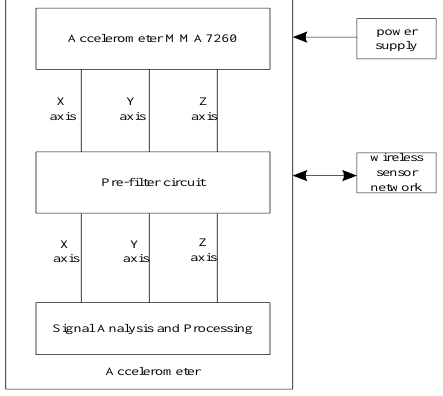
Figure 5. Structure diagram of acceleration sensor The acceleration sensor composed of MMA7260 collects the gait acceleration data in the front and rear, left and right, up and down directions of the human